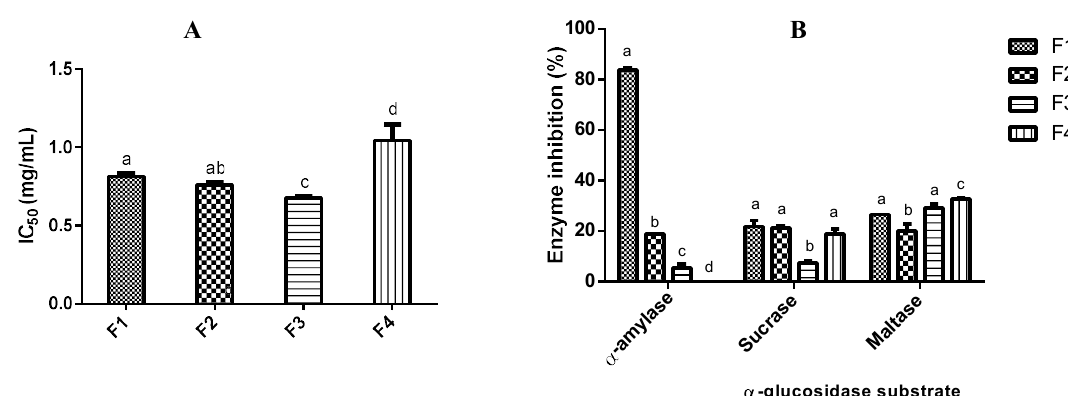
Figure 2. Dipeptidyl peptidase-IV (DPP-IV) (expressed as IC 50 or peptide concentration needed to inhibit by 50% the original enzyme activity), α -amylase and α -glucosidases (expressed as % inhibition) inhibitory activities of peptide fractions collected by RP-HPLC from 5–10 kDa fraction obtained from germinated soybean protein digest (6GSPD). Peptide fractions (F1–F4) were tested at a dose of 1 mg/mL for α -amylase and α -glucosidases inhibitory assays. Values are the mean ± standard deviation. Different letters indicate significant differences among samples ( p ≤ 0.05, Holm-Sidack’s test).